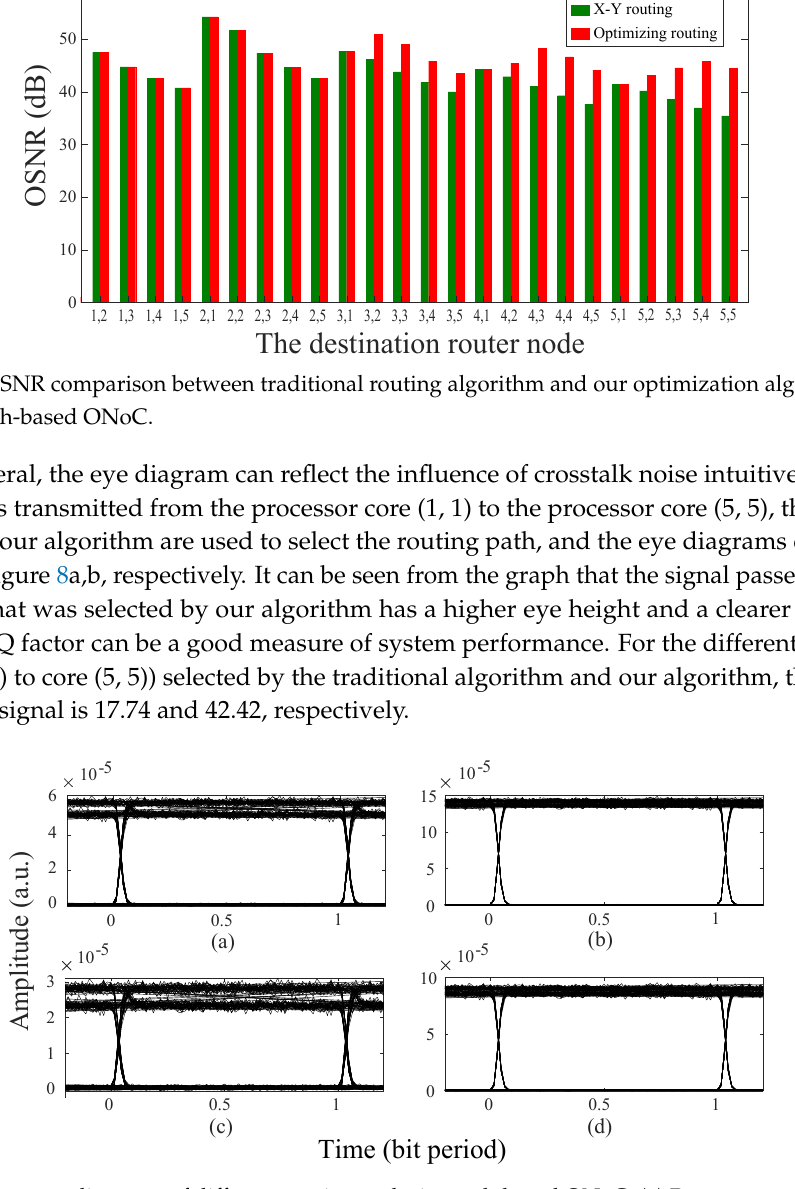
Figure 8. Four eye diagrams of different routing paths in mesh-based ONoC. ( a ) Processor core (1, 1)